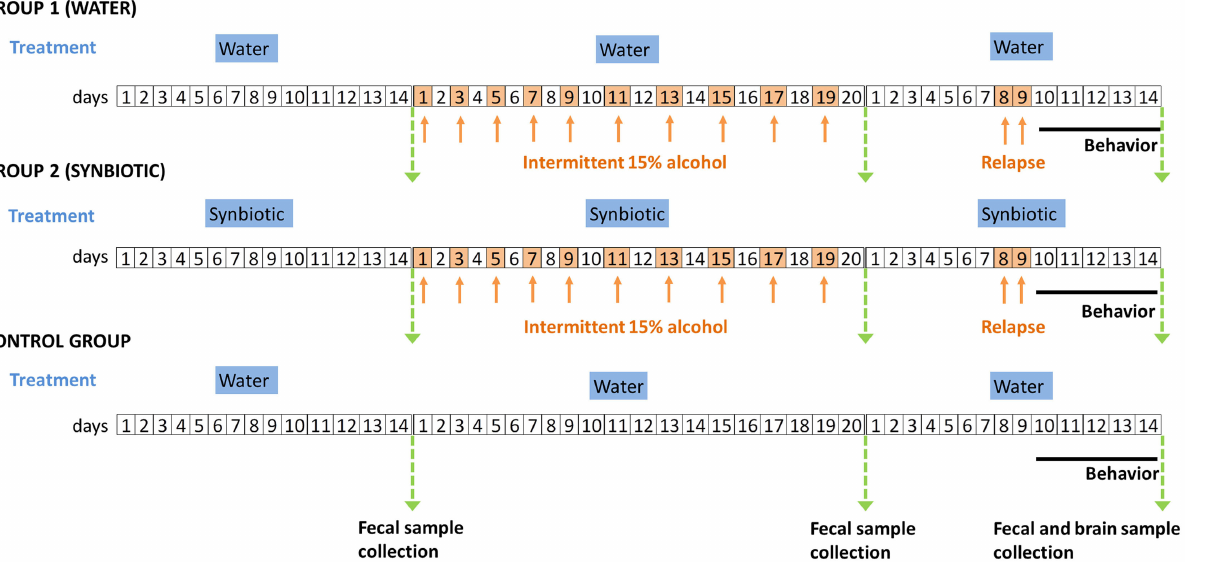
FIGURE 1 | Schematic diagram of the experimental procedures followed in the study. Group 1 (males and females) were treated with water and Group 2 (males and females) were treated with synbiotic during the entire procedure. The control group was treated with water and never received alcohol, and was included in the post-relapse behavioral analyses. The timeline of the experiments (days) is shown in squares. White squares represent days where mice drank water plus the corresponding treatment (in blue titles), and orange squares (and arrows) represent the days where mice drank alcohol (15% ethanol solution in water) plus the corresponding treatment. Green arrows represent the days of sample collection. The solid black line indicates the days of post-relapse behavioral testing.